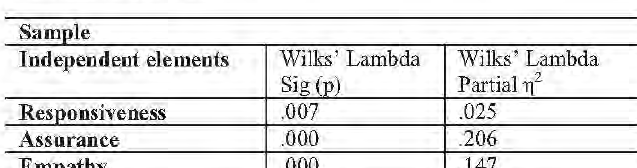
Table 3: Multivariate regression for the four dependent elements of brand image and four independent elements of service